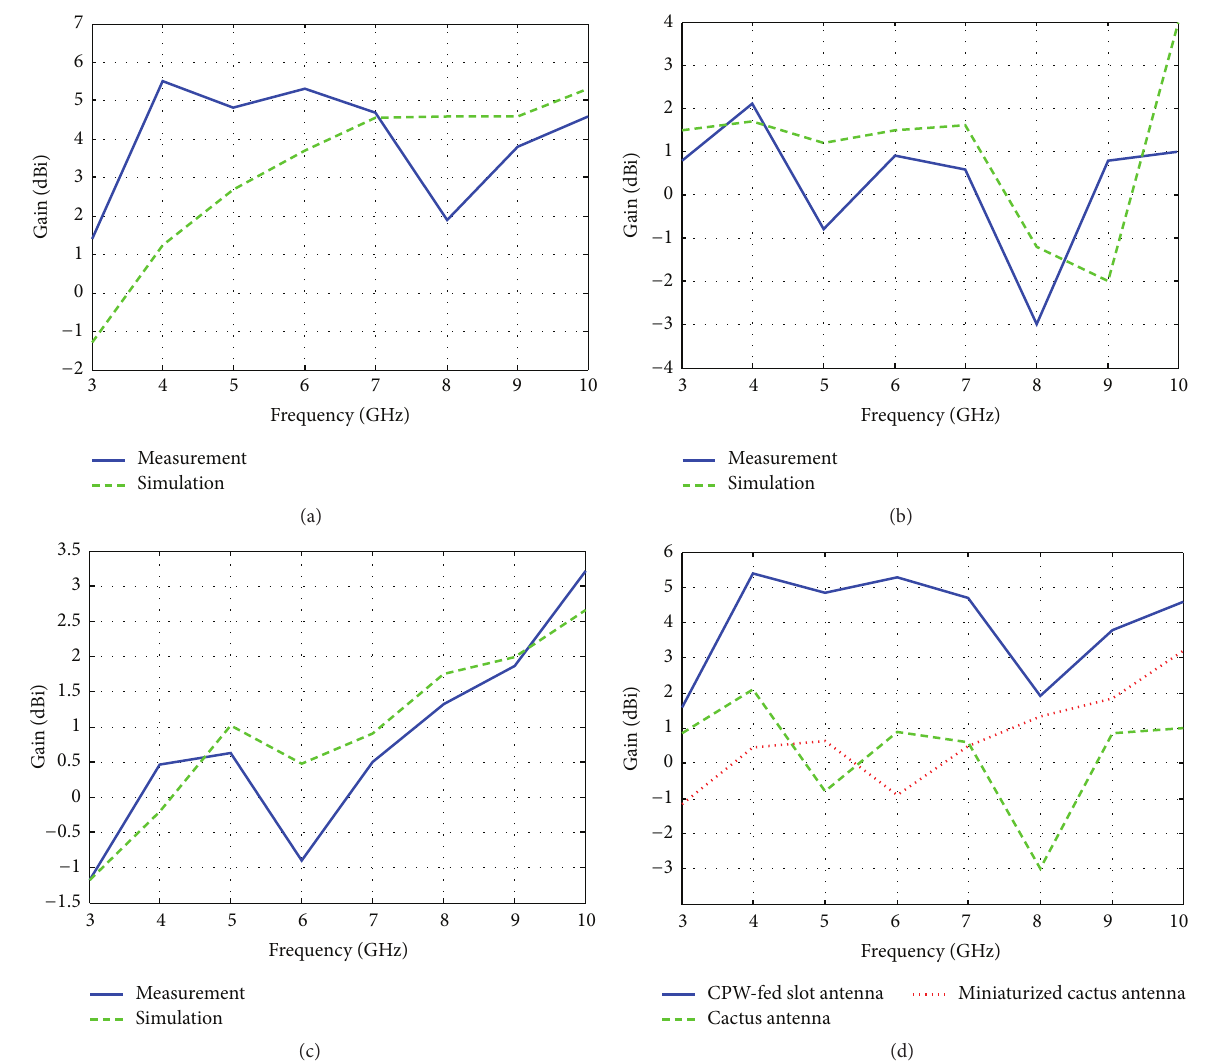
Figure 11: Simulated and measured gain comparison for (a) CPW-fed slot antenna, (b) cactus antenna, and (c) miniaturization cactus antenna and (d) comparison of measured gain for all three